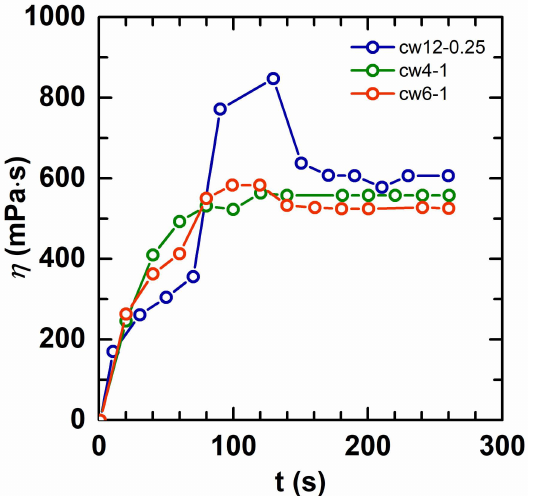
Figure 2. The solubility of HAPAM w / w emulsion in water. The polymer concentration is fixed at